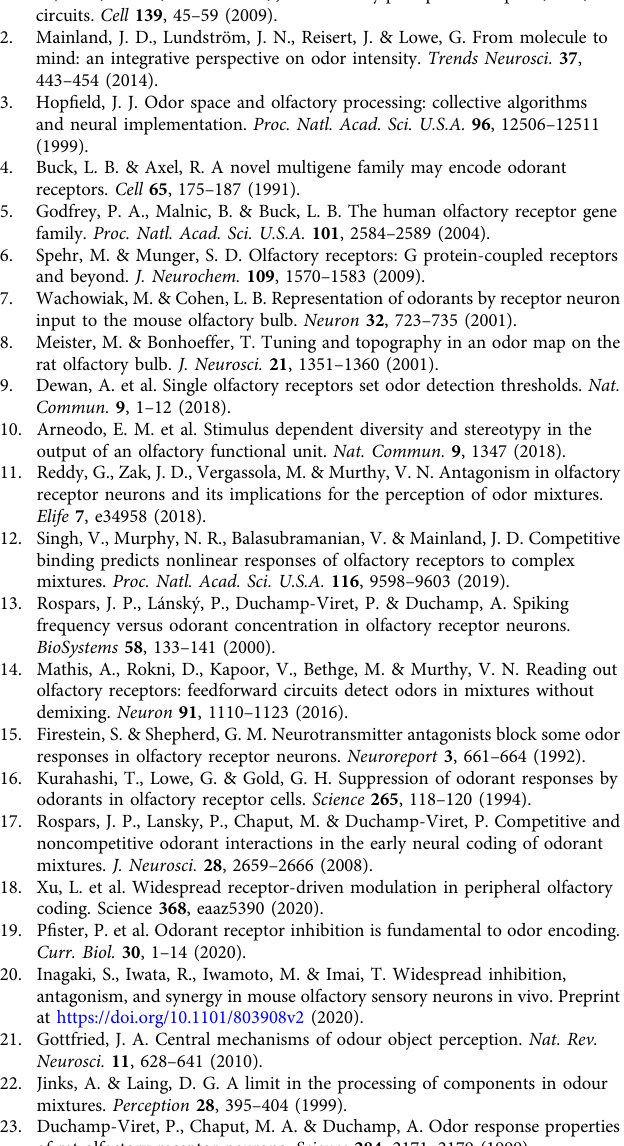
Data analysis . Images were processed using both custom and available MATLAB (Mathworks) scripts. Motion artifact compensation and denoising was done using NoRMcorre 64 . For experiments imaging OSN axon terminals in the olfactory bulb, regions of interest (ROIs) were manually selected by outlining glomeruli in max- imum projection images. For epithelium imaging, the CaIMaN CNMF pipeline 65 was used to select and demix ROIs. ROIs were further fi ltered by size and shape to remove merged cells. For all mixture experiments, the peak Δ F/F signal was cal- culated by fi nding the peak signal following odor onset and averaging with the two adjacent points. The mean Δ F/F signal in the 20 frames following odor onset was used for odor tuning experiments. To account for changes in respiration frequency and anesthesia depth, correlated variability across replicates was corrected for 14 . Thresholds for classifying responding ROIs were determined from a noise dis- tribution of blank (no odor) trials from which three standard deviations were used for responses. Across all datasets, only ROIs with at least one signi fi cant odor response were included for further analysis. Measurements of binary mixture non- linearities used individual trial replicates of the three highest odor concentrations used in each